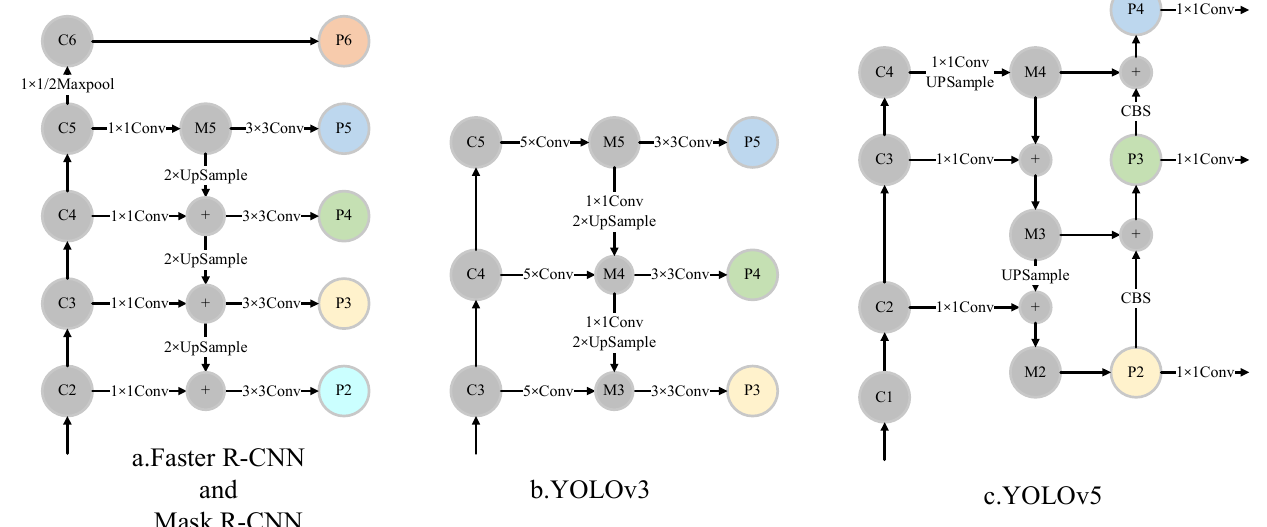
Figure 1. Different feature fusion structures.